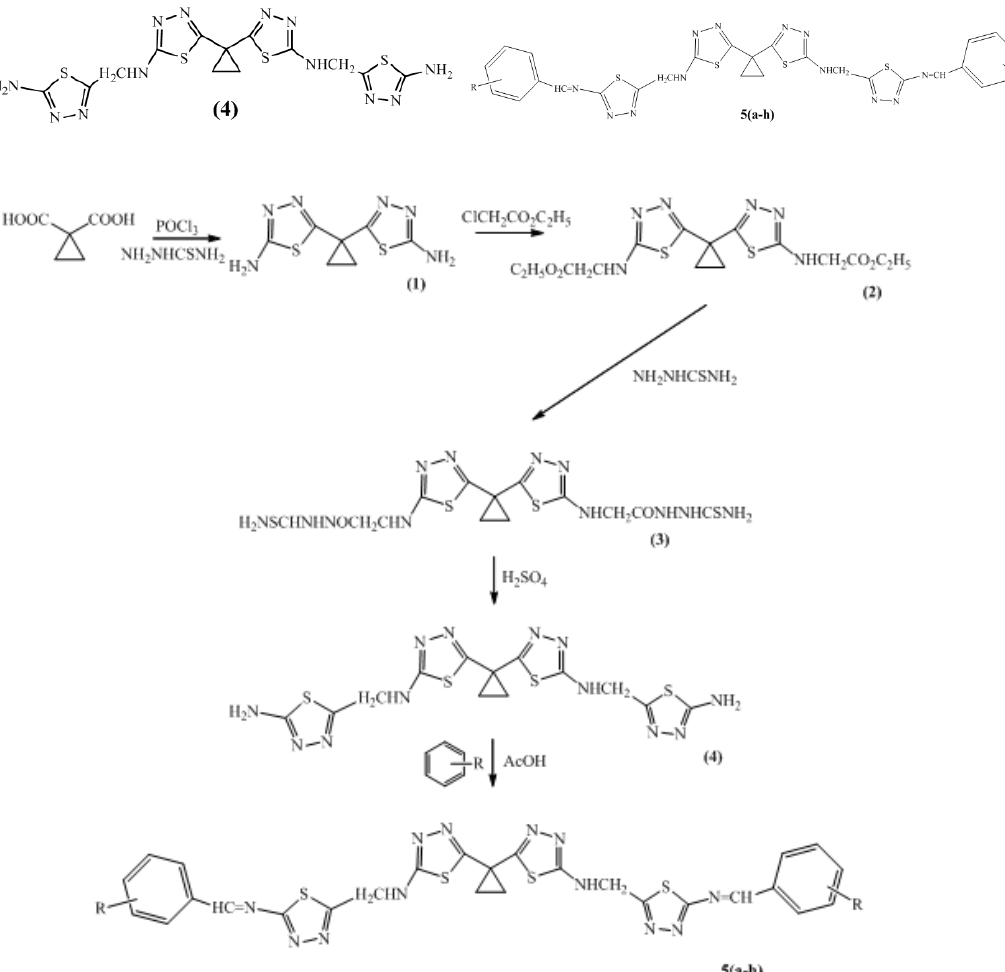
Figure 1. The synthesis of target derivatives, schiff bases i.e. 1, 1- Bis [2-{2-(5-(arylidene)imino- 1,3,4-thiadiazol-2-yl) methyl amino}- 1,3,4-thiadiazo-5-yl] cyclopropane 5(a-h) were afforded by the reaction of different aromatic aldehydes with compound (4) in presence of glacial acetic